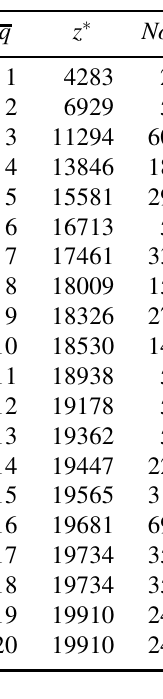
Table 5. Computational results for C